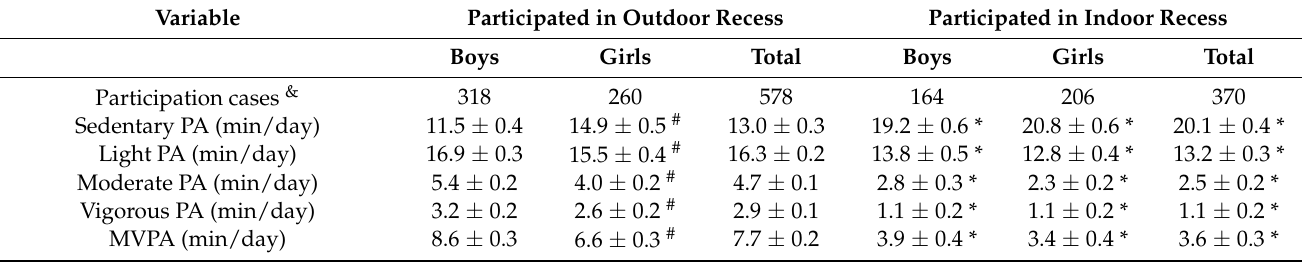
Table 3. Differences in time spent in different activity levels (mean ± SE) during outdoor/indoor